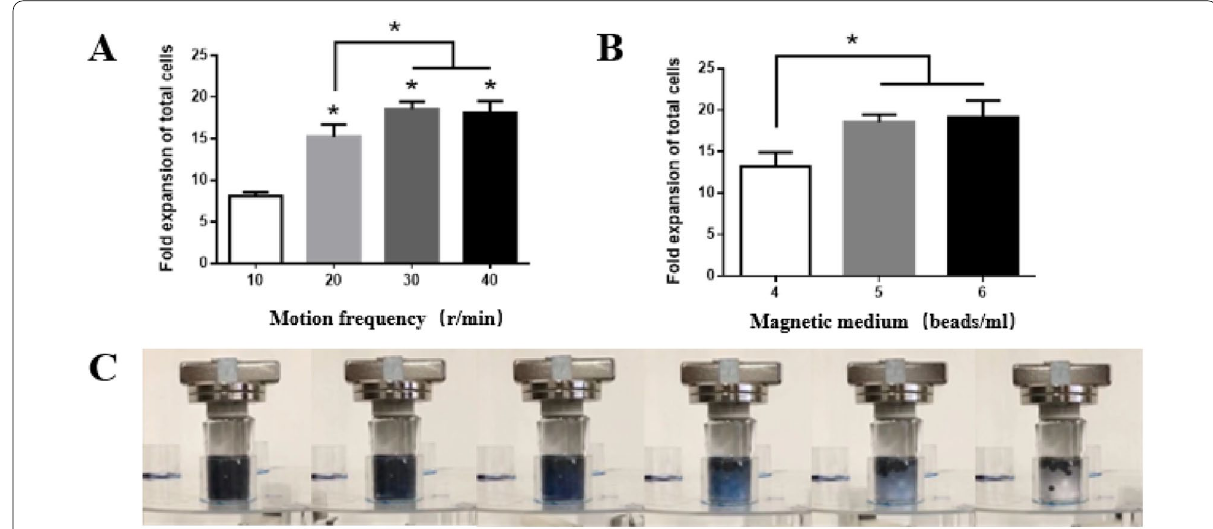
Fig. 5 Optimization of culture conditions in magnetically controlled bioreactor. A NK‑92 cell expansion fold at different rotation speeds. B NK‑92 cell expansion fold at different magnetic beads densities. C Images of the effect of mixing medium in the rotational frequency of the crossbar